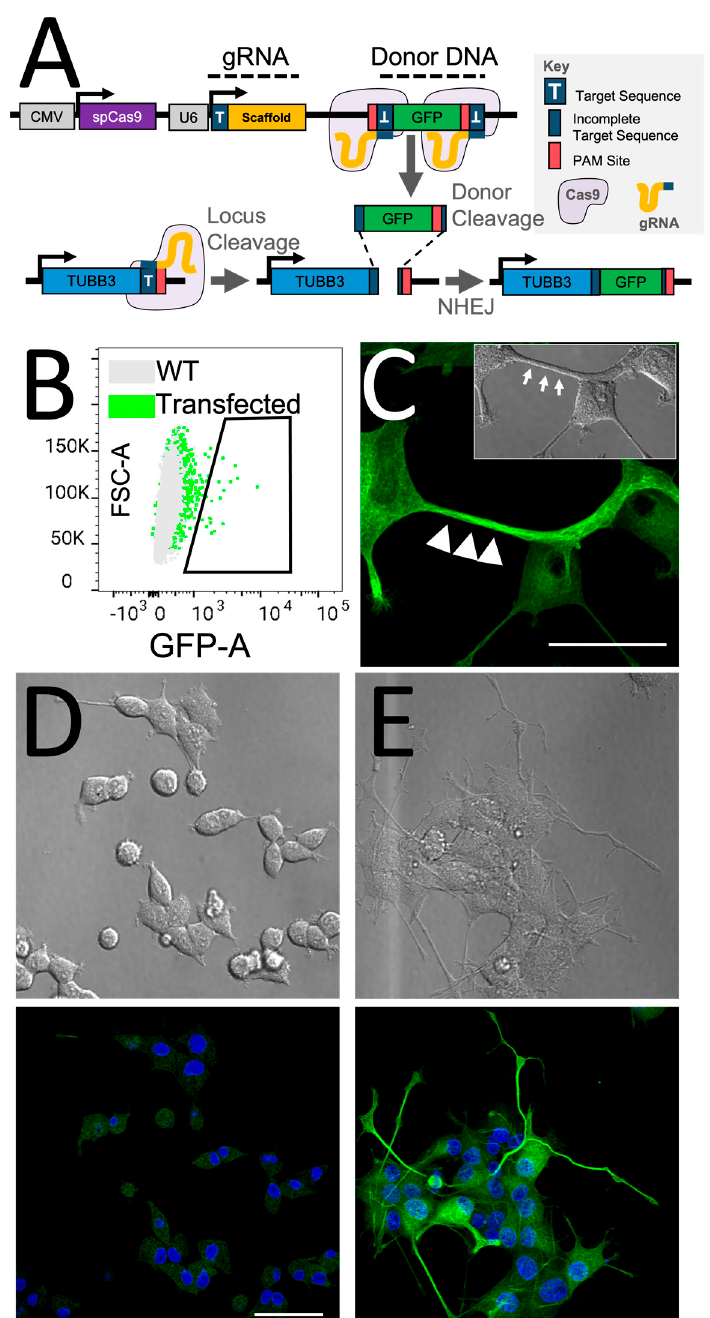
Figure 2. CRISPR/Cas9-based HITI approach for experimental labeling of endogenous β 3-tubulin. ( A ) To generate a culture of PC12-TUBB3-GFP cells, neuronal PC12 precursors were transfected with the vector containing Cas9, sgRNA, and the GFP reporter donor sequence, which integrates into the β 3-tubulin locus. We used a single vector that contains spCas9 controlled by a constitutive CMV promoter, the gRNA controlled by a U6 promoter, and the GFP donor DNA sequence flanked by target sequences that match the genomic TUBB3-targeted region. The gRNA creates a double-strand break and removes the GFP donor DNA from the plasmid for genomic integration of GFP at the β 3-tubulin locus target sequence. The correct orientation of GFP is ensured by the reverse orientation of the target sequence sites and protospacer-adjacent motif (PAM) compared to the TUBB3 locus. This design allows Cas9 to self-correct GFP its orientation if integration occurs backward. ( B ) Strategy to isolate PC12 culture transfected with the knock-in vector. Cells were sorted using fl uo- rescence-activated single-cell sorting (FACS) to select cells that acquired GFP fl uorescence signal as presented in the dot plot (transfected). Wild-types (WT) cells served as control. GFP + cells were